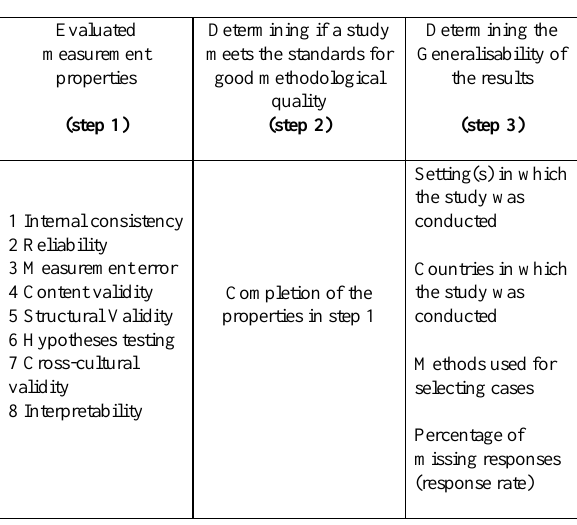
Table 2. Instructions for completing the COSMIN